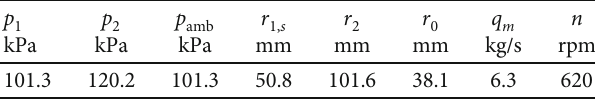
Table 11: Parameters of the radial pump used in the hybrid